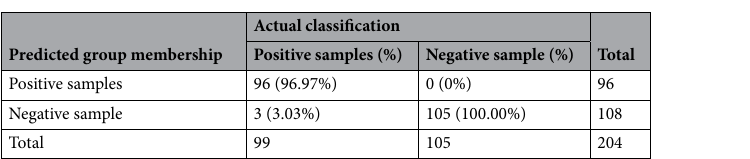
Table 3. Classification results of back-substitution method. . McNemar’s test: P =